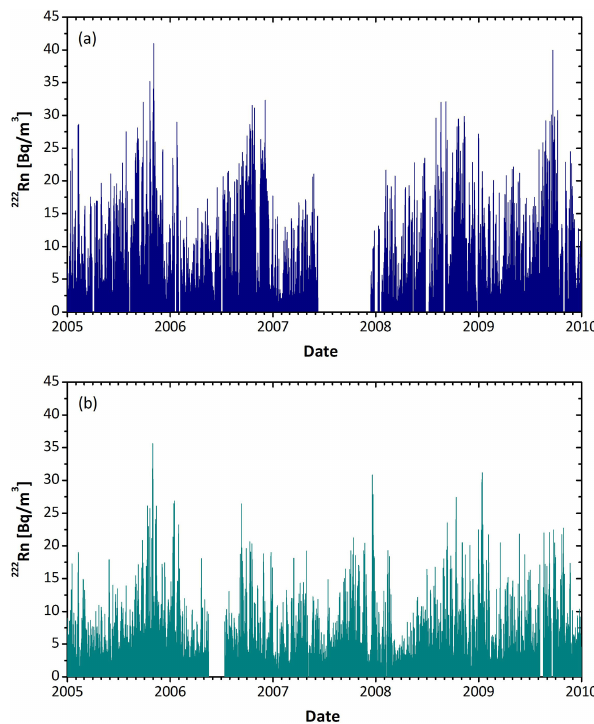
Figure 1. Time series of hourly mean 222 Rn content in the near- ground atmosphere, recorded between January 2005 and December 2009 in Krakow, southern Poland (a) , and Heidelberg, south-west Germany (b)